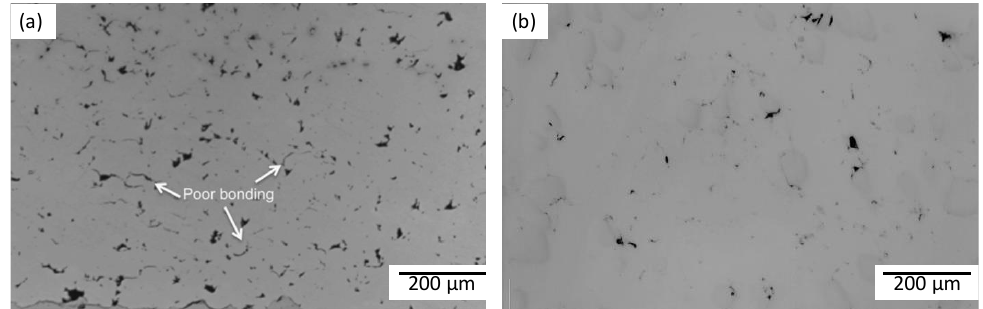
Figure 4. OM image of cold-sprayed ( a ) IN718 coating, adapted from [20], ( b ) 50% IN718 – 50% Ni coating produced for this study.